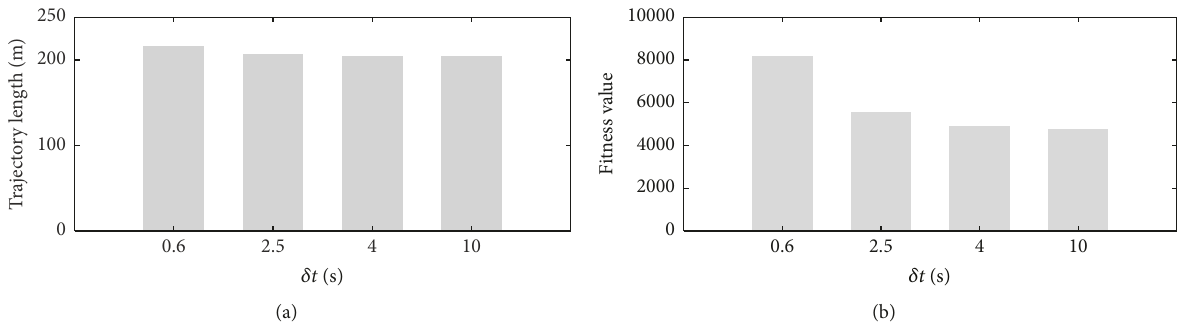
Figure 13: Performance criterion: (a) trajectory length and (b) fitness value, respectively.